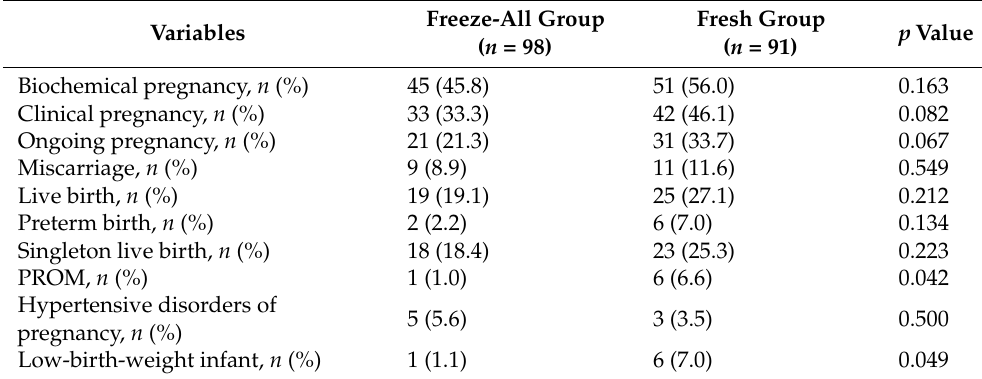
Table 3. Pregnancy outcomes and obstetric complications between freeze-all and fresh groups.